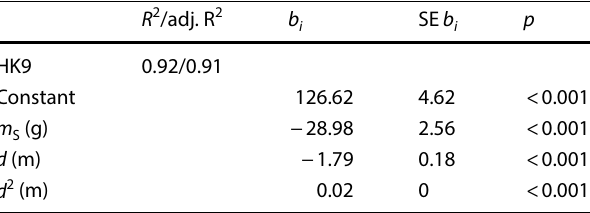
Table 5 Coefficients of the polynomial regression model for the electrode HK9. m is the mass of deposited weld material and d is S the water depth: the 𝛽 i values are not stated, because the inclusion of d 2 leads to collinearities, SE stands for standard error R 2 /adj. R